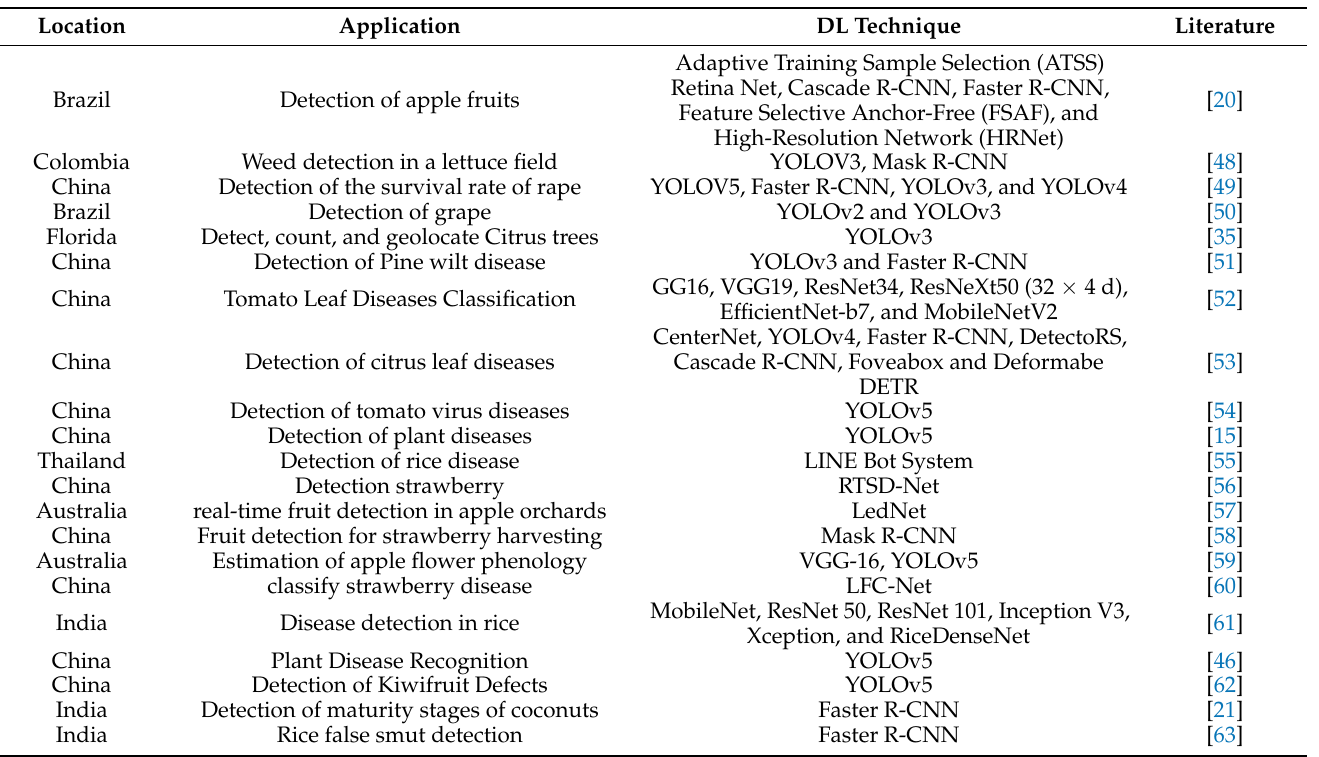
Table 1. Application of DL techniques in precision